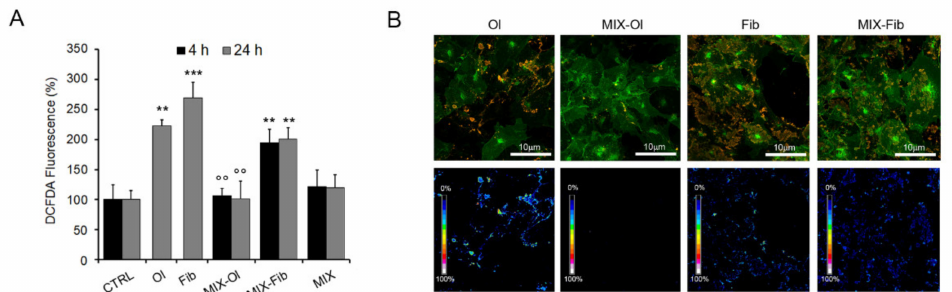
Figure 2. Polyphenols MIX effects on A β 1–42 cells sufferance. ( A ) ROS levels in SH-SY5Y cells treated for 24 h with 2.5 µ M A β 1–42 oligomers (Ol) or fibrils (Fib) in absence or after pre-treatment with the 75 µ M MIX (MIX-Ol, MIX-Fib) for 4 h (black bars), 24 h (grey bars) assessed by CH2-DCFDA probe. DCFDA fluorescence is reported as percentage respect to untreated control cells. Error bars indicate the standard error of three independent experiments carried out in triplicate. **: p -value < 0.01; ***: p -value < 0.001 vs. untreated control cells. ◦◦ : p < 0.01 vs. A β 1–42 aggregates-treated cells. ( B ) Confocal microscopy showing the co-immunolocalization of A β 1–42 aggregates (Ol, Fib) and the membrane GM1 ganglioside in SH-SY5Y cells in absence (Ol, Fib) and in presence of pre-treatment with the MIX for 24 h (MIX-Ol, MIX-Fib). The cells were stained with Alexa 488-conjugated CTX-B probe (green staining); A β 1–42 aggregates were stained with anti-A β 1–42 primary antibody and then with Alexa 568-conjugated anti-rabbit secondary antibody (red fluorescence). FRET efficiency is shown in bottom